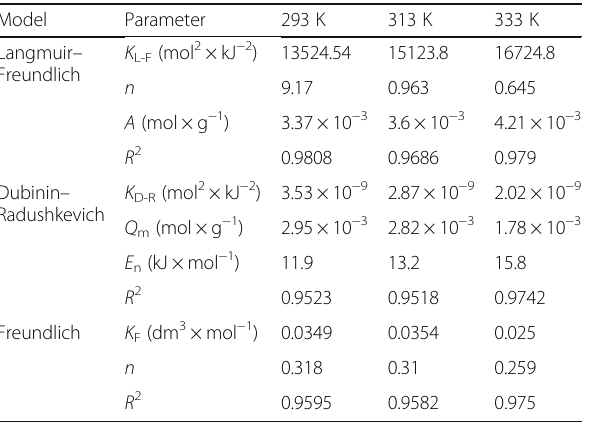
Table 7 Parameters of the isotherm models for the adsorption of U(VI) ions on the HAP, ( R 2 – correlation) Model Parameter